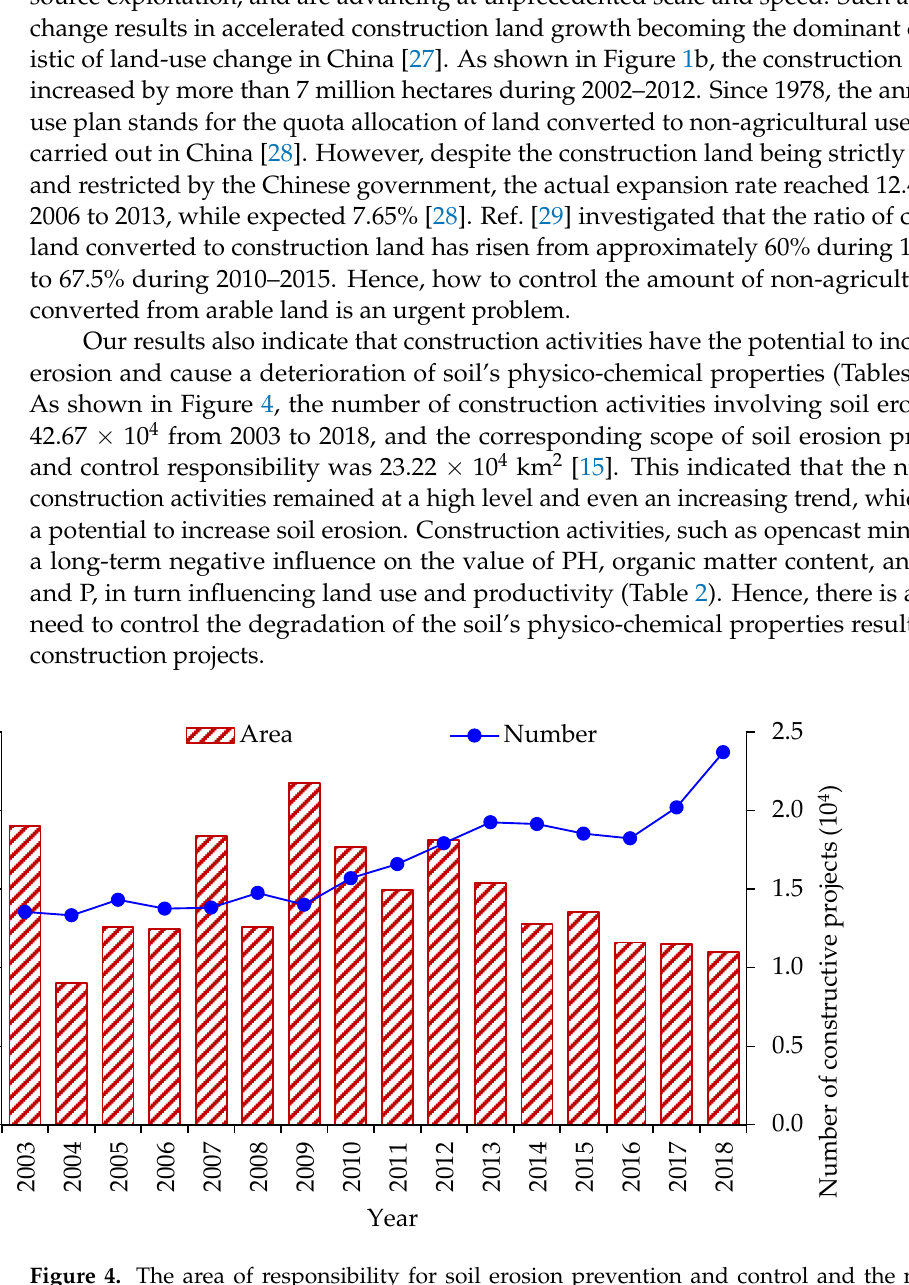
Figure 4. The area of responsibility for soil erosion prevention and control and the number of Figure 4 The area of responsibility for soil erosion prevention and control and the num- constructive projects in China from 2003 to ber of constructive projects in China from 2003 to 2018.